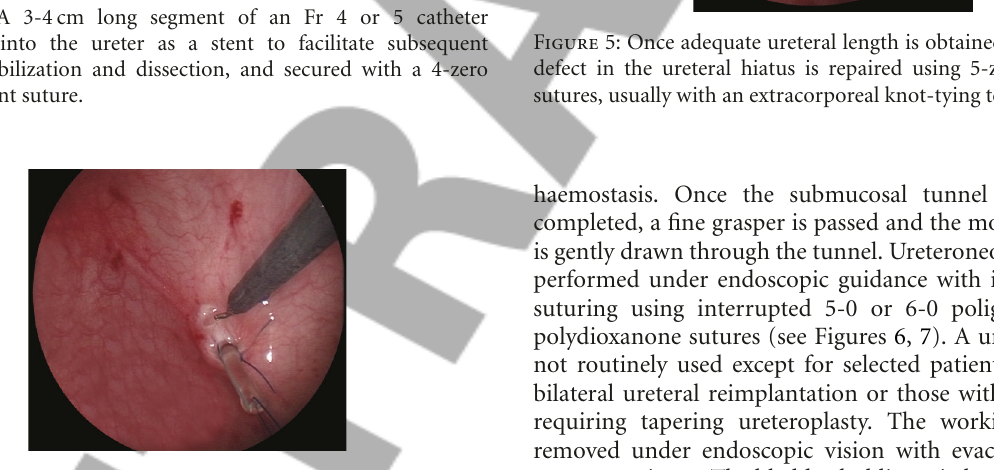
Figure 3: The ureter is mobilized by first circumscribing it around the ureteral orifice using hook electrocautery.